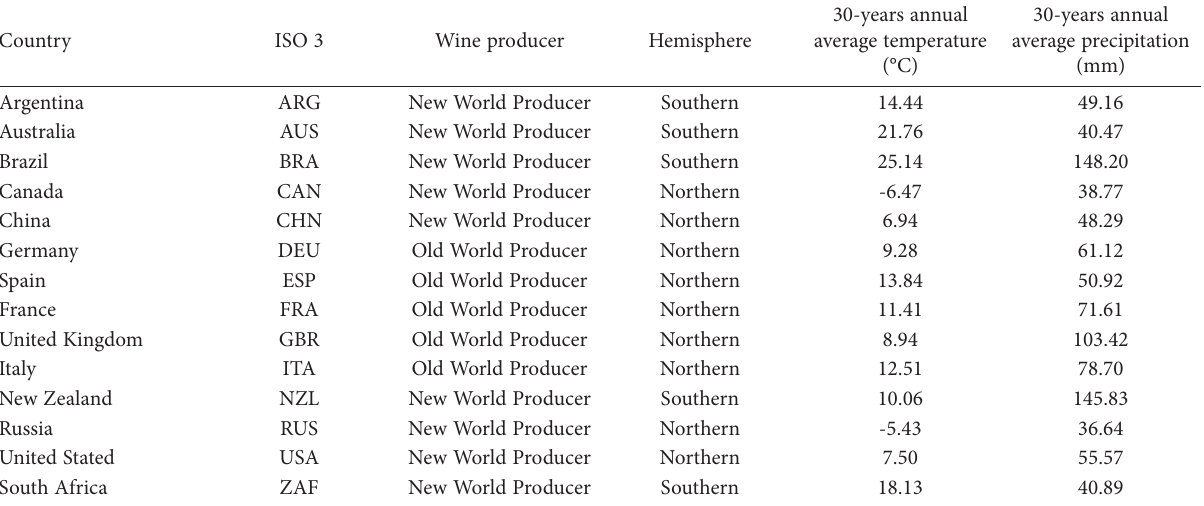
Table A.1. List and description of countries in the